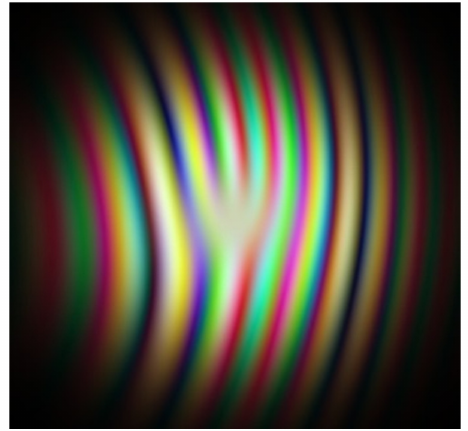
Figure 4. Interference of a Left Circularly Polarized Component.